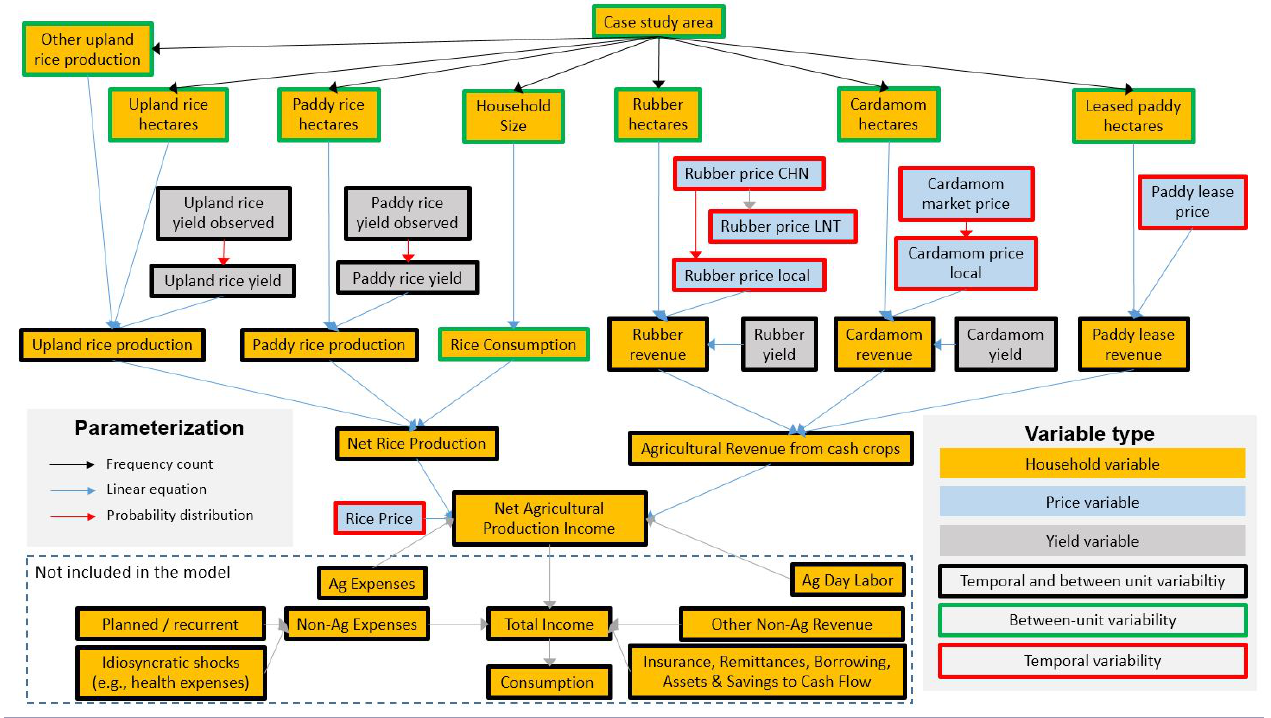
Fig. 2 . Schematic of the Bayesian network model indicating variable type and parameterization method. Each box represents a variable in the model, implemented as a discretized probability distribution. Alternatively, variables can be “instantiated” (fixed) to a certain value. CHN = China, LNT = Luang Namtha